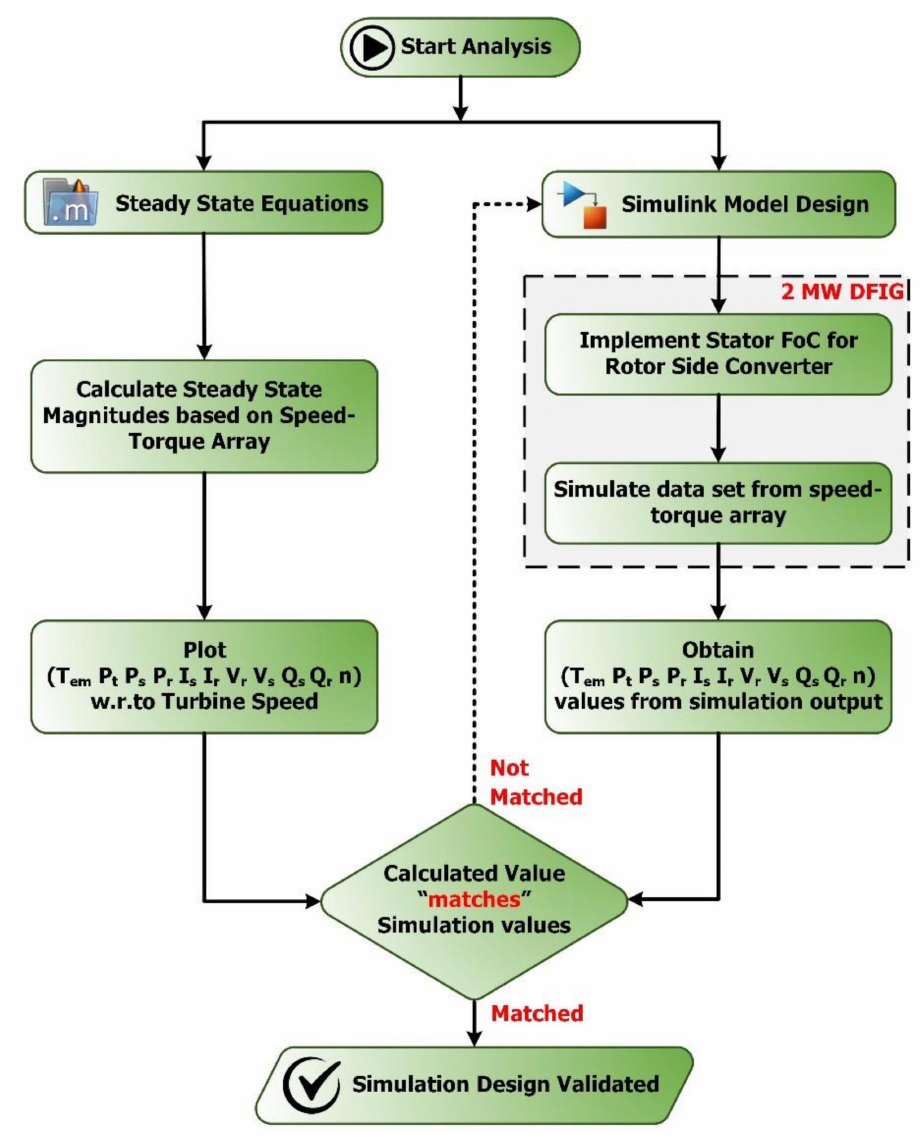
Figure 6. Process of DFIG’s SS performance